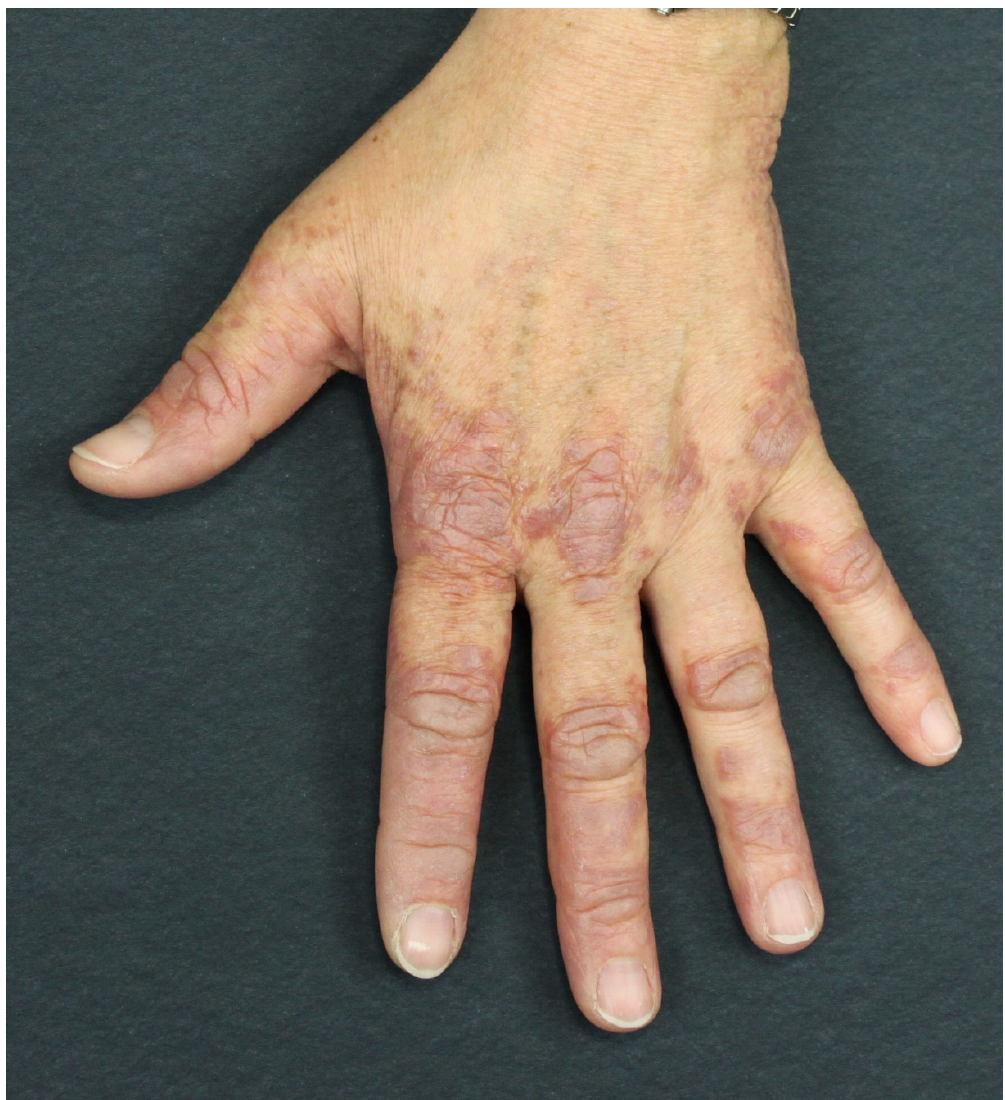
Figure 5. Paraneoplastic dermatomyositis (Gottron’s papules). Slightly elevated, purplish lesions on an erythematous background over bony prominences, mainly on the metacarpophalangeal, interphalangeal, and distal interphalangeal joints.